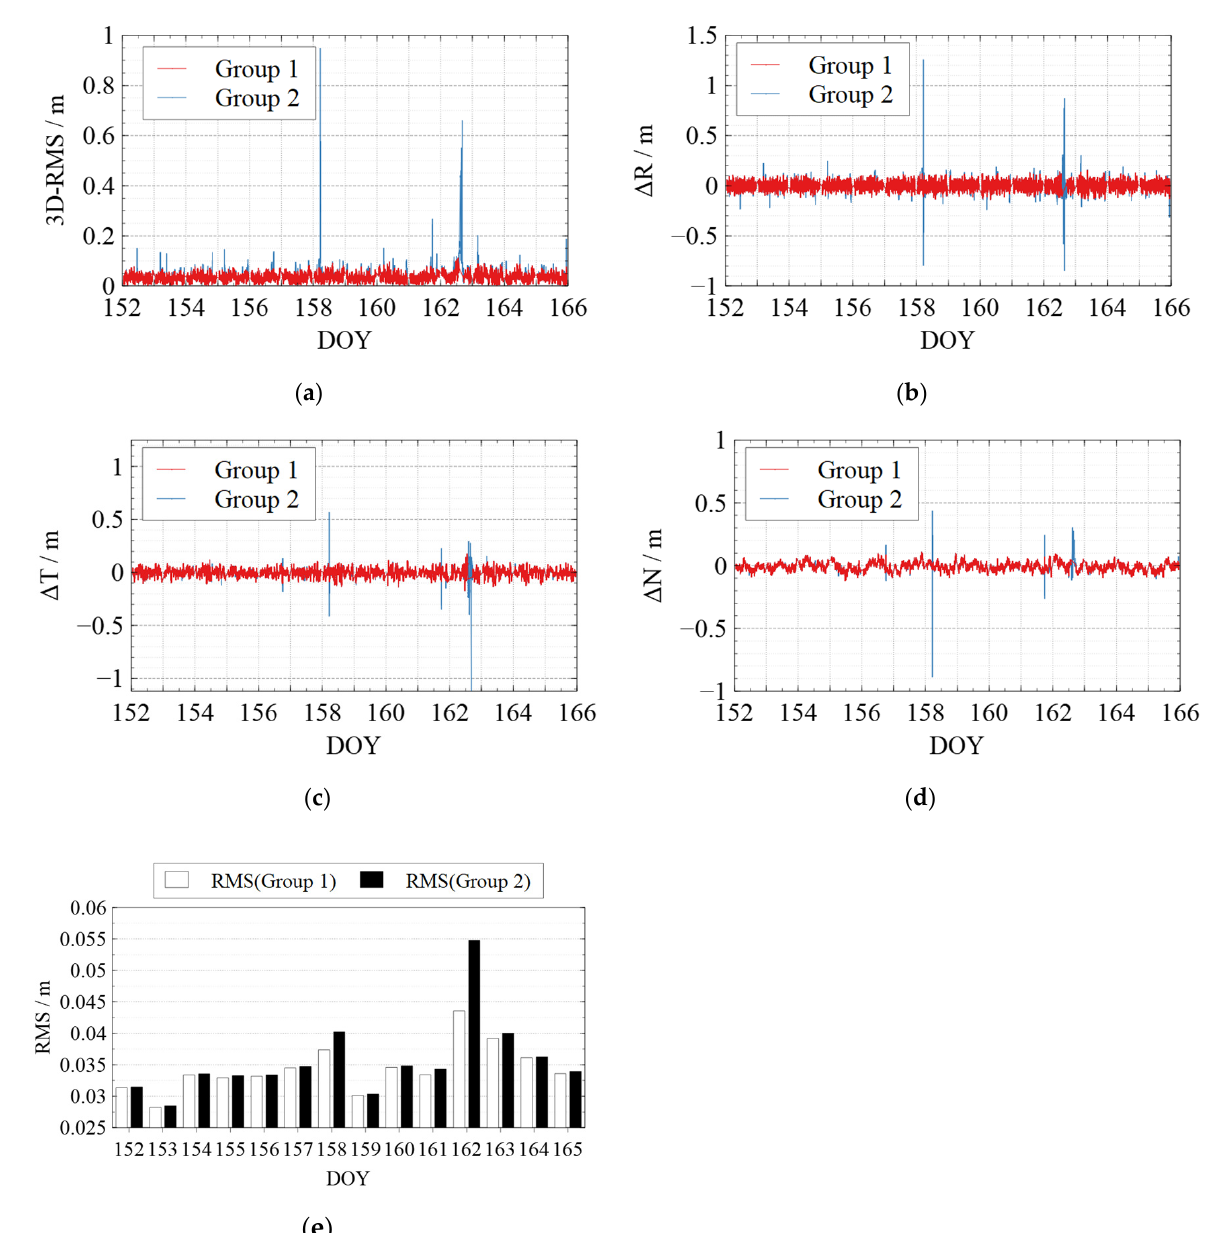
Figure 8. Comparison between the kinematic orbits of Swarm-C and precise orbits provided by the ESA. ( a ) 3D-RMS of the comparison results; ( b ) Difference in Radial direction; ( c ) Difference in Tangent direction; ( d ) Difference in Normal direction; ( e ) Average 3D-RMS statistics of the comparison results. The red line shows the results of Group 1, while the blue line shows the results of Group 2 in ( a – d ). The white blocks and black blocks in ( e ) represent the RMS of Group 1 and Group 2 on each day, respectively.